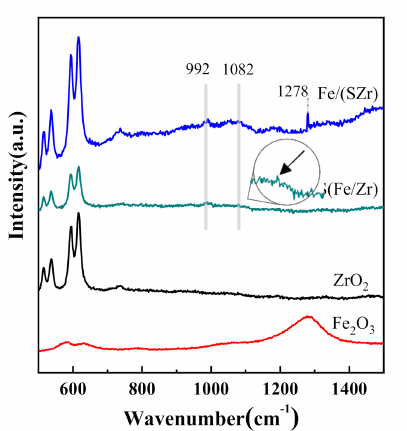
Figure 3. Raman patterns of di ff erent iron-based catalysts.